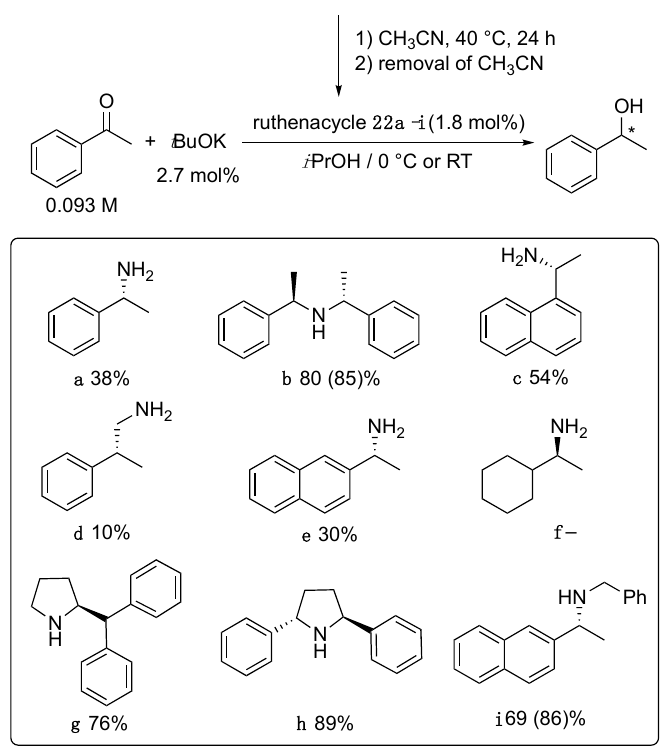
Scheme 13. HTE screening of chiral amines in Pfeffer’s ATH of acetophenone ( ee given below